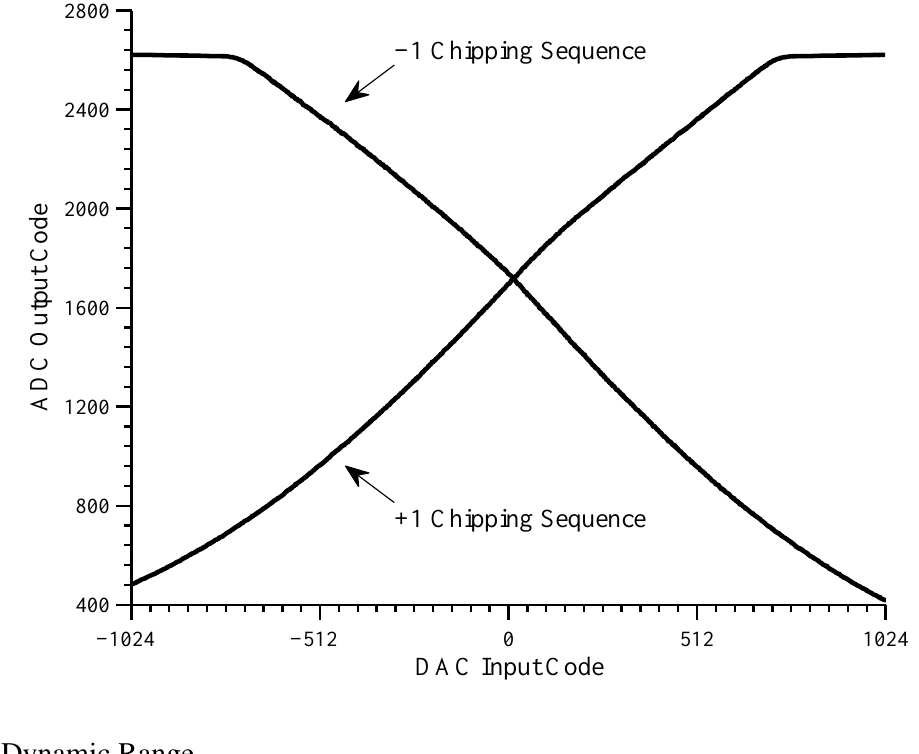
Figure 10. Channel transfer